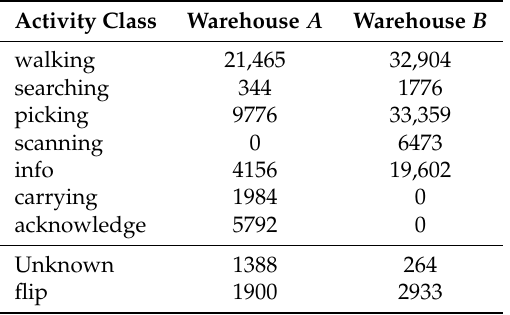
Table 1. Overview of the Order Picking dataset and number of frames for each of the activity classes in the different parts of the dataset